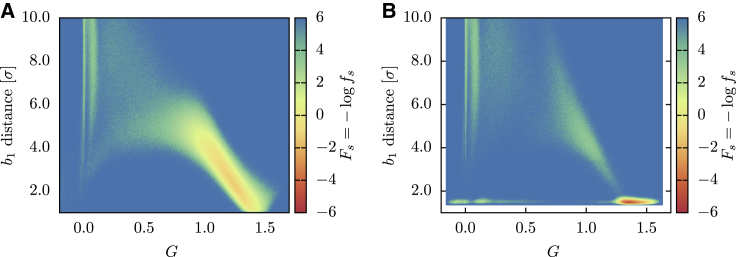
Successful folding landscape Fs of the HM as a function of the Gauss linking number G and of the b1 bridge distance. (A) Successful trajectories (N = 1970) in reducing conditions. (B) Successful trajectories (N = 1946) in oxidizing conditions. To see this figure in color, go online.